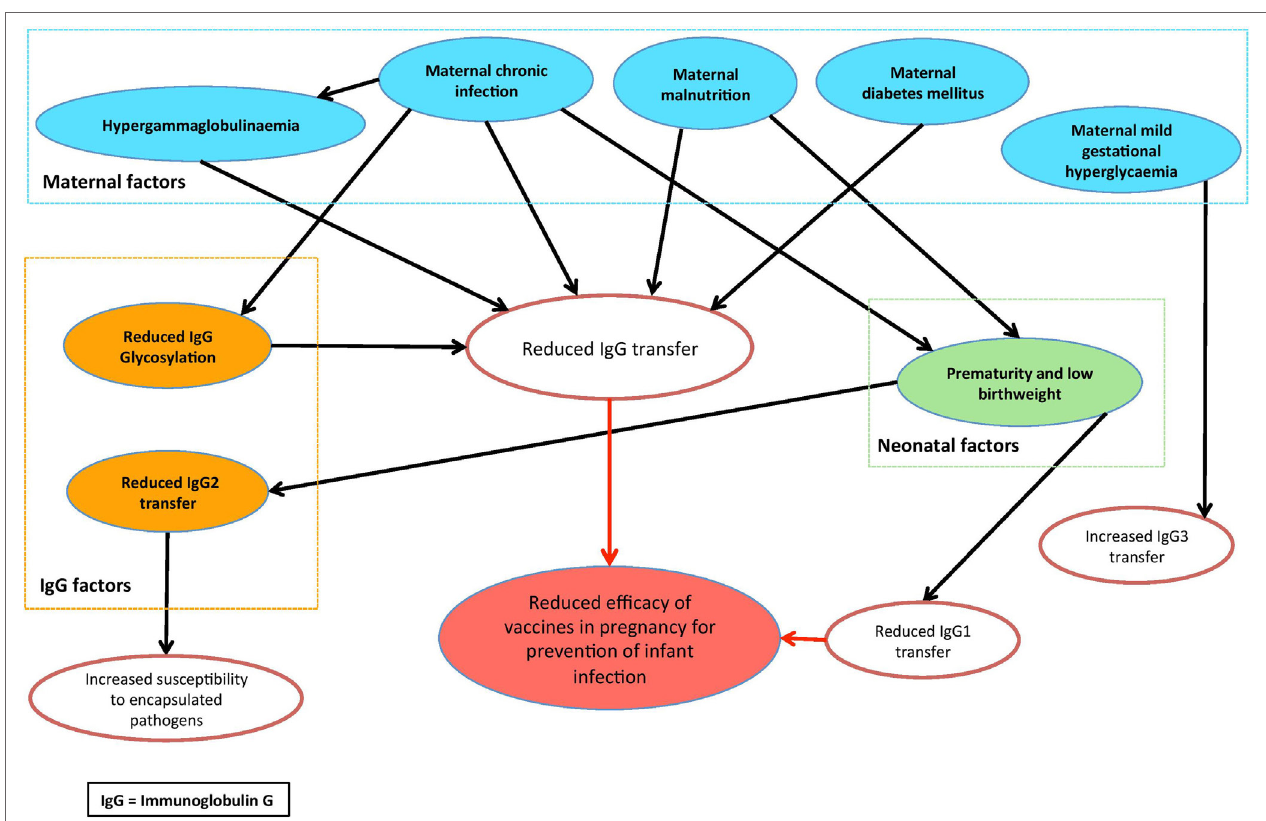
FiGURe 3 | Conceptual diagram of the factors that may modulate placental antibody transfer of relevance to maternal